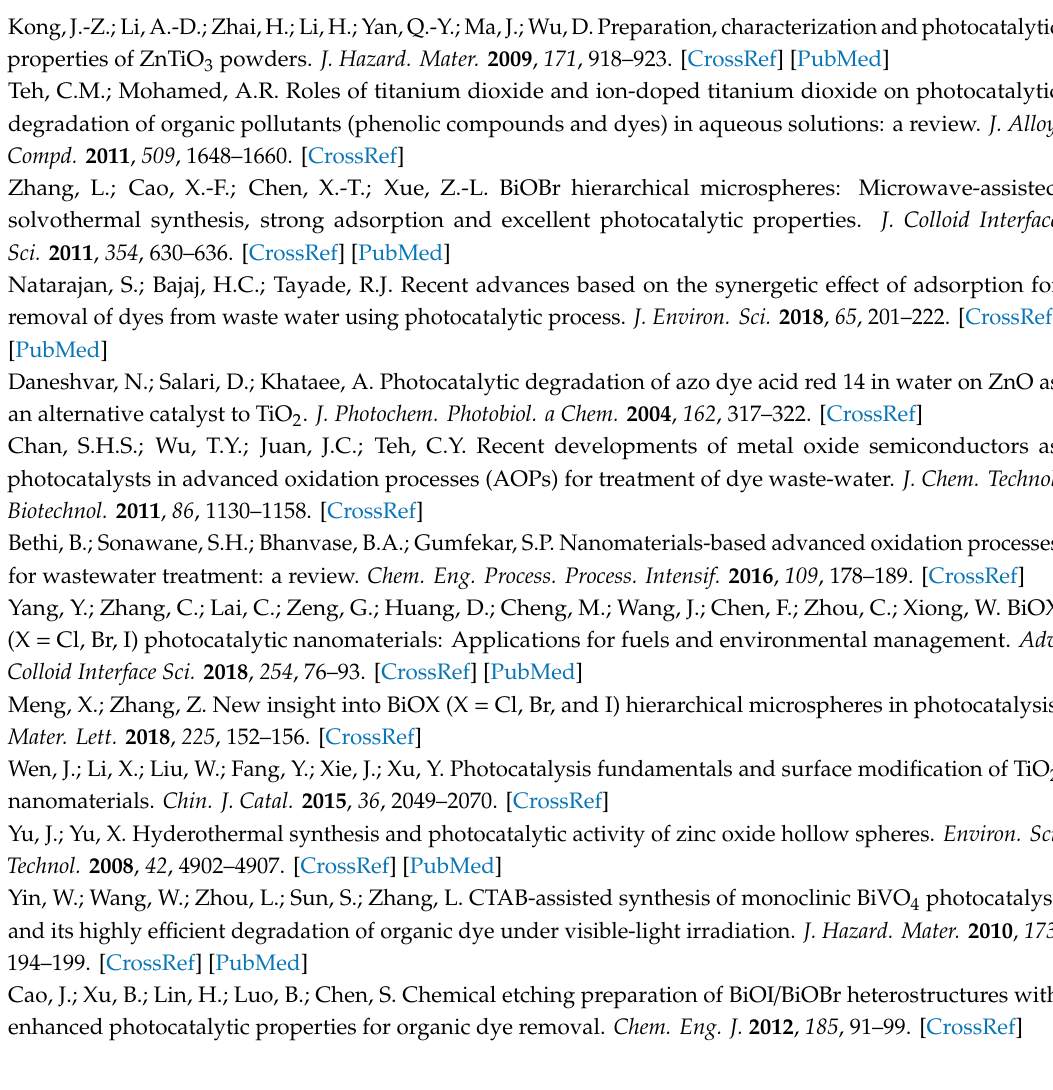
Figure S1: (a) XPS wide scan spectrum of GO; (b,c) XPS high resolution spectra of GO: (b) C 1s and (c) O 1s; Figure S2: SEM images of